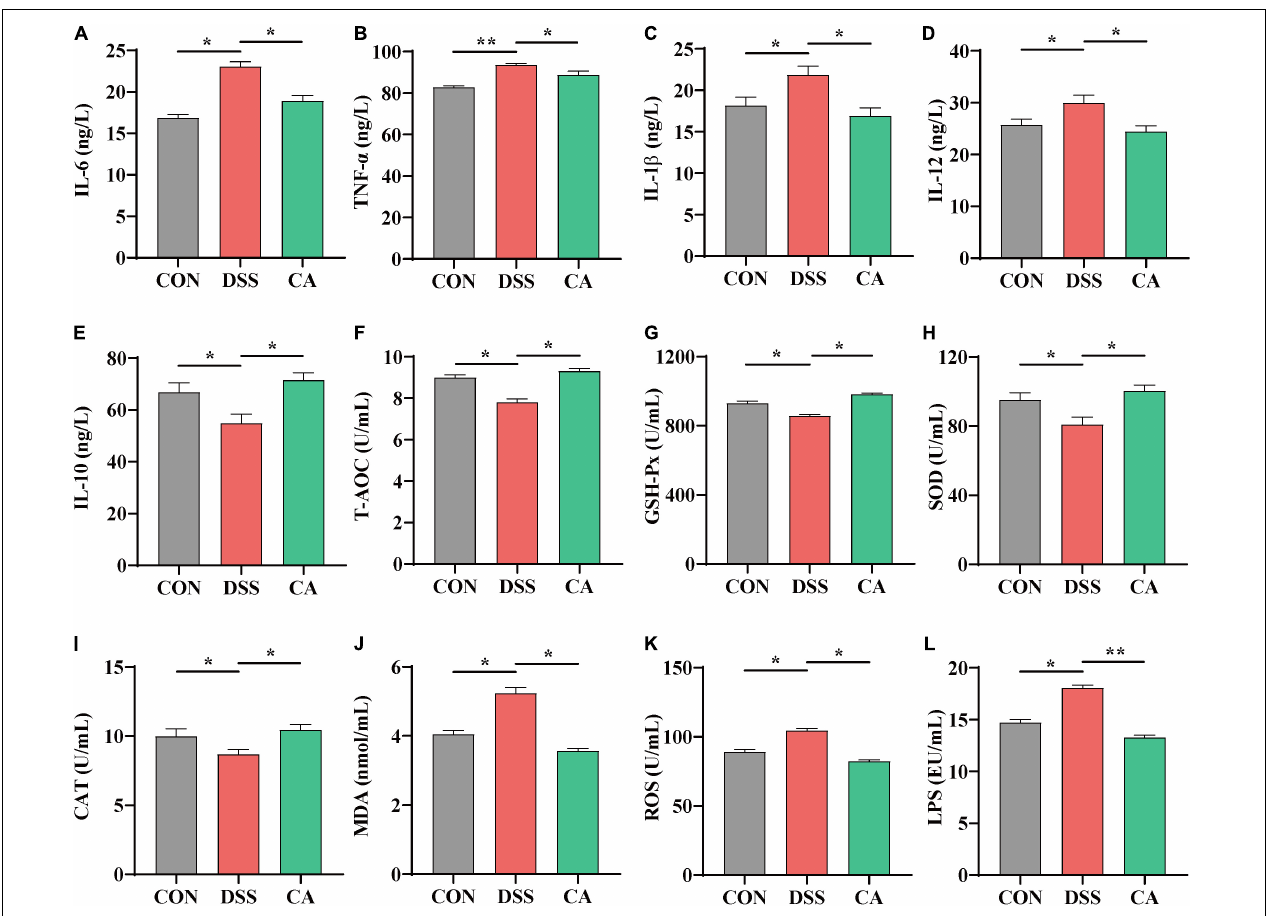
FIGURE 3 | Effects of CA supplementation on the serum inflammation cytokine and antioxidant parameters in DSS-induced colitis mice. (A) IL-6. (B) TNF- α . (C) IL-1 β . (D) IL-12. (E) IL-10. (F) T-AOC. (G) GSH-Px. (H) SOD. (I) CAT. (J) MDA. (K) ROS. (L) LPS. Data are presented as mean ± SEM; n = 10. * p < 0.05 and ** p < 0.01 vs. the DSS-treated